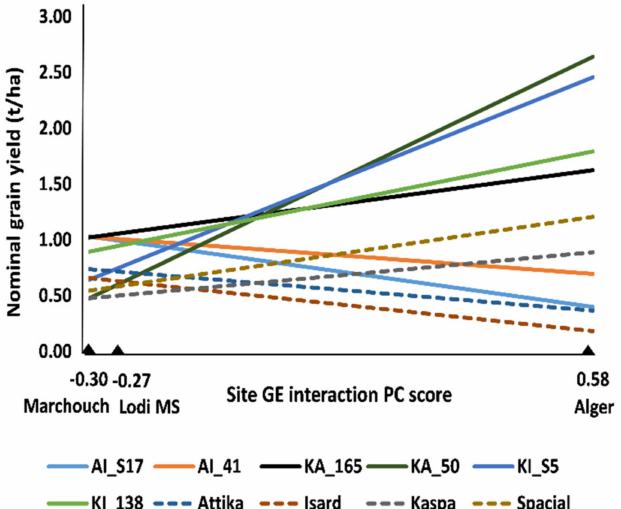
Figure 1. Additive Main e ff ects and Multiplicative Interaction (AMMI)-modeled nominal grain yield of a set of top-performing pea lines out of 288 lines belonging to three connected recombinant inbred line (RIL) populations, including the two top-ranking lines in each site or over sites, three parent cultivars (Attika, Isard, and Kaspa) and one recent control cultivar (Spacial), grown in a managed drought stress (MS) environment of Lodi (Italy) and two agricultural environments of Marchouch (Morocco) and Alger